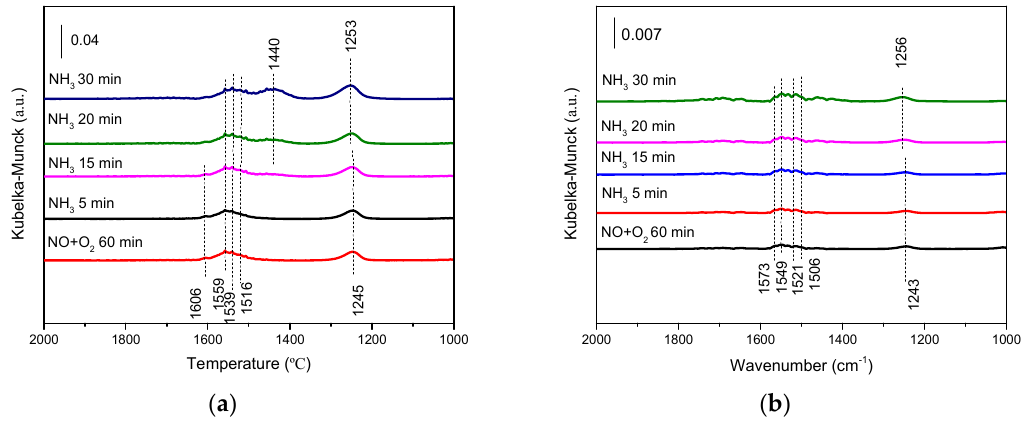
Figure 11. The in situ DRIFT of NH 3 reacting with preadsorbed NO+O 2 over ( a ) the SbCeZr and ( b ) the SbCe catalysts at 200 °C.